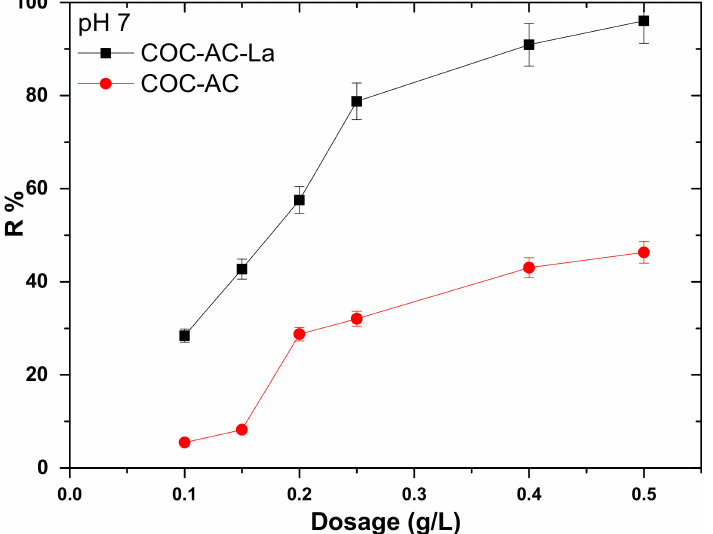
Figure 3. Effect of COC-AC-La dose on Cr(VI) adsorption, in comparison with COC-AC; initial Cr(VI) concentration 100 µ g/L, pH 7.0 ± 0.1, T = 22 ± 1 ◦ C, contact time 24 h, in deionized